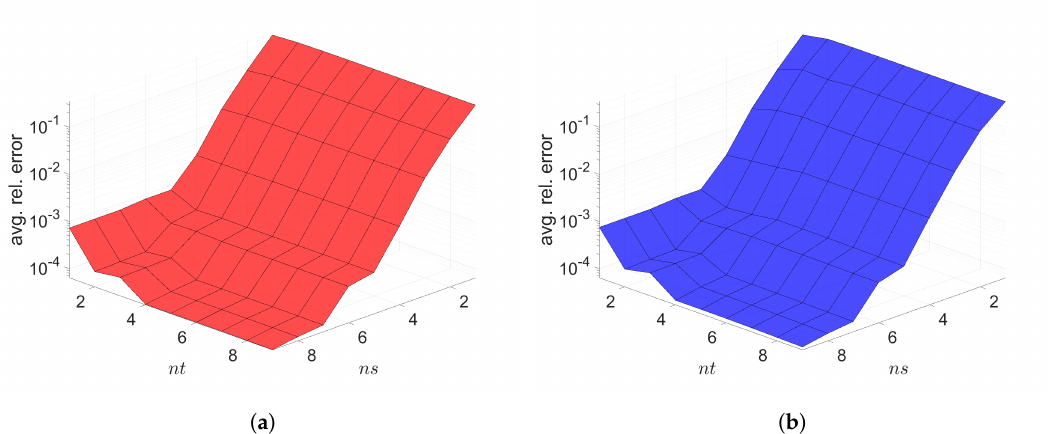
Figure 12. 2D linear convection diffusion equation. Relative errors vs. reduced dimensions. Note that the scales of the z -axis, i.e., the average relative error, are the same both for Galerkin and LSPG. Although the Galerkin achieves slightly lower minimum average relative error values than the LSPG, both Galerkin and LSPG show comparable results. ( a ): Relative errors vs. reduced dimensions for Galerkin projection, ( b ): Relative errors vs. reduced dimensions for LSPG